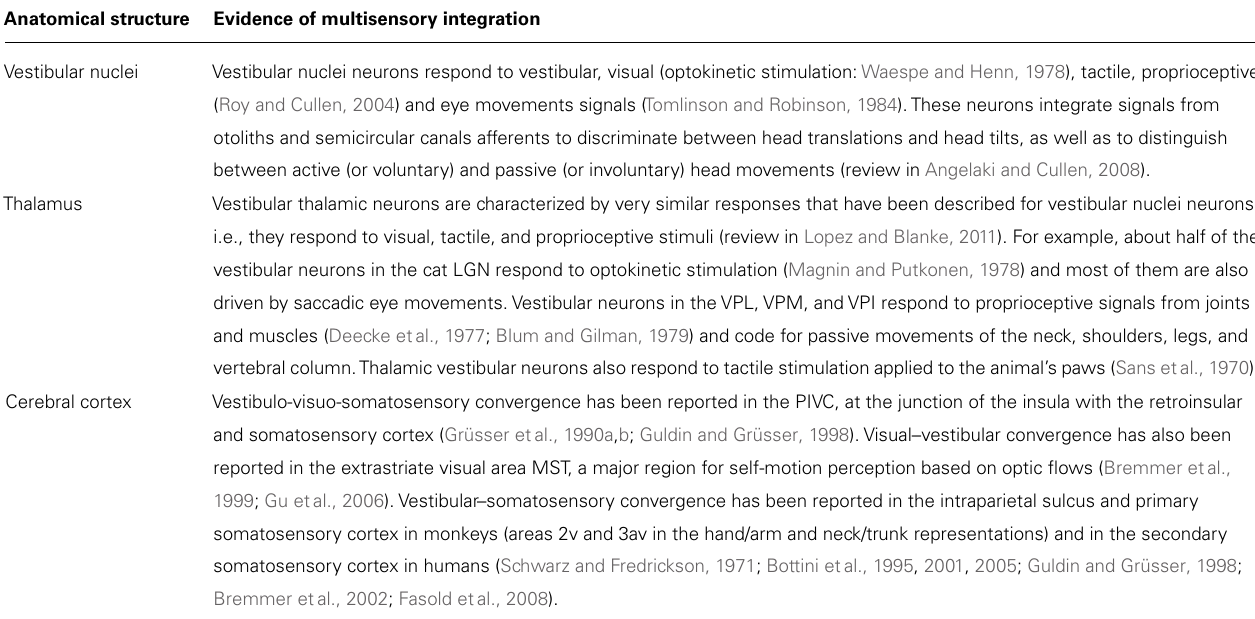
Table 1 | Evidence of multisensory integration in three vestibulo-thalamo-cortical structures. Anatomical structure Evidence of multisensory